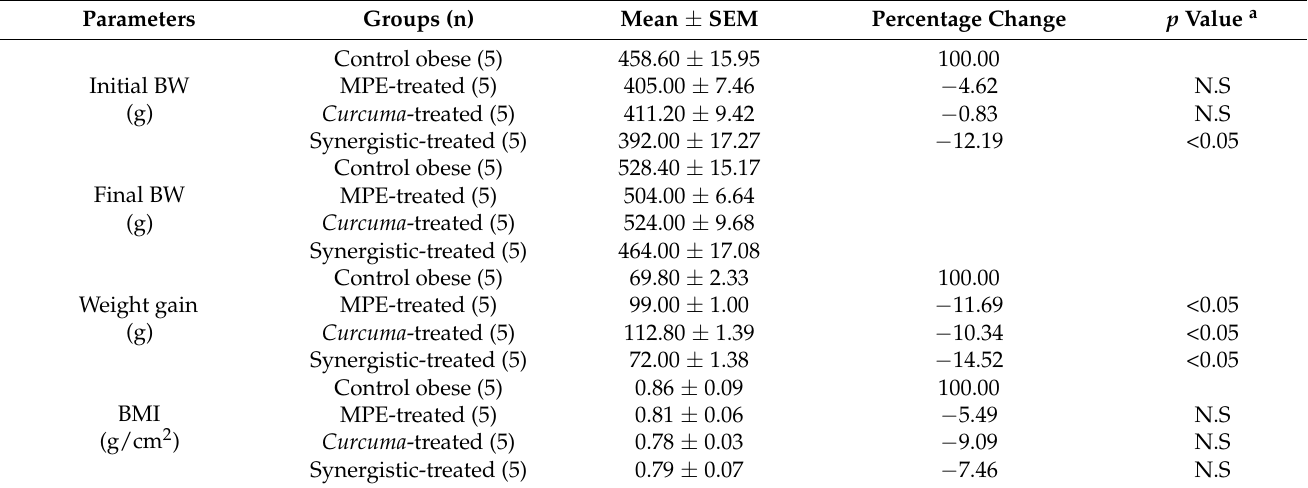
Table 3. Independent and synergistic effects of C. longa and G. mangostana extracts on BMI of lean and HFT-induced obese